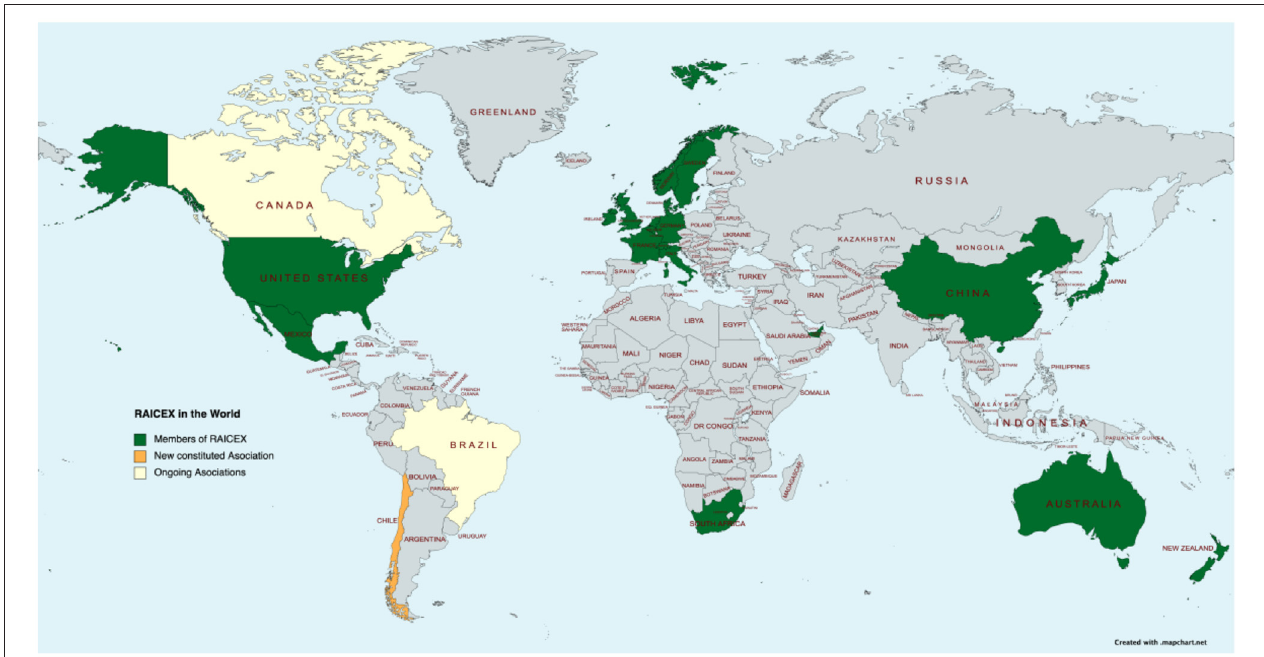
FIGURE 2 | The world-wide presence of RAICEX members. Green color represents active members; Orange color represents new constituted associations yet to sign the incorporation agreement; Yellow color represents incoming new association. The figure represents data from 2012 to 2022.